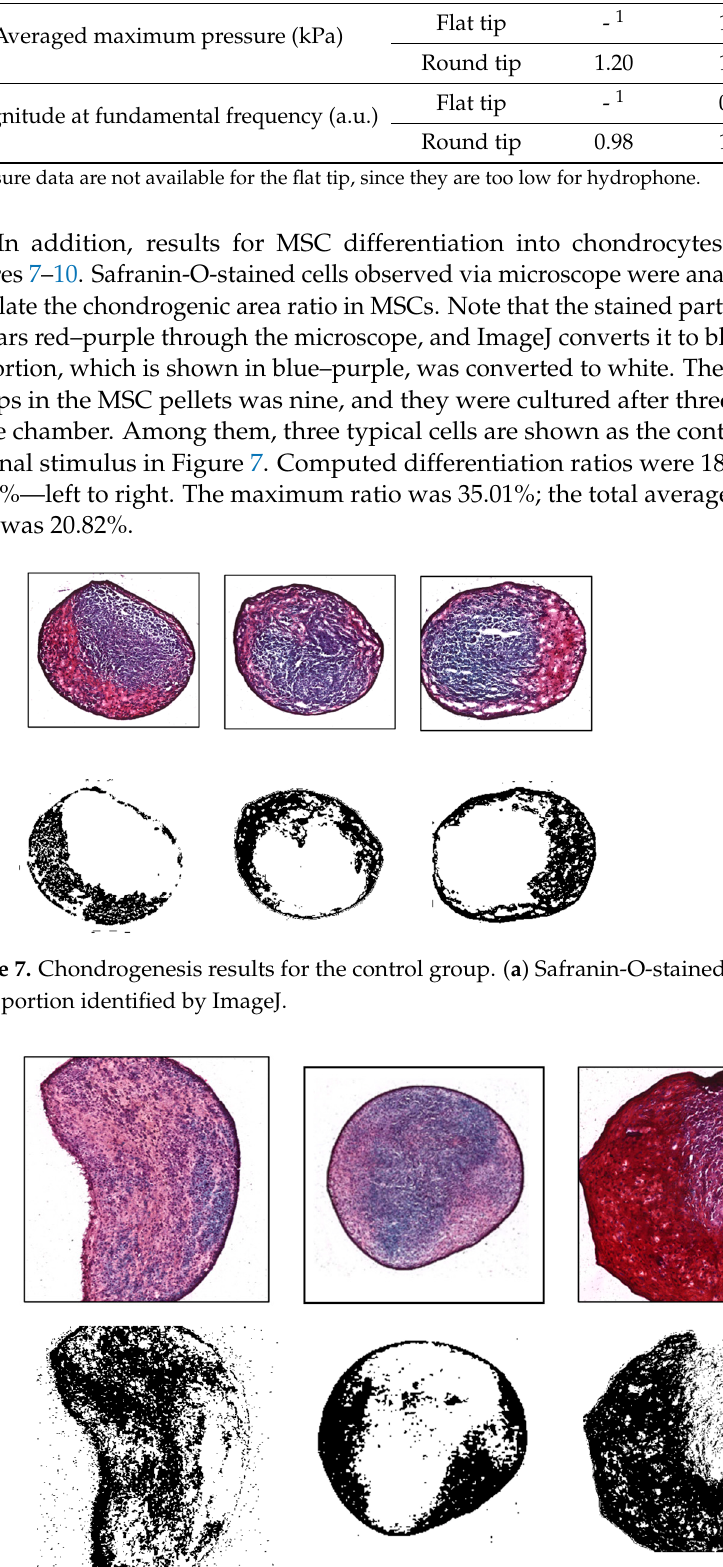
Table 1. List of pressure calibration based on tip shape.